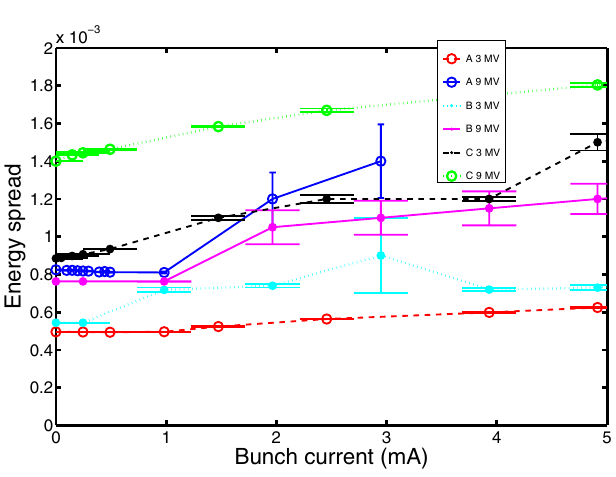
FIG. 10. (Color) Energy spread as a function of current (up to 5 mA) by considering all the wakefield contributions.